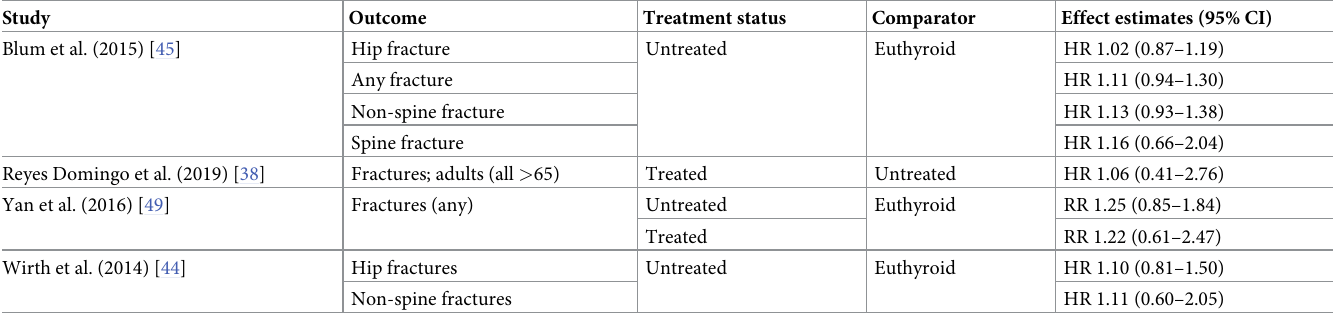
For the 5 studies that explicitly reported quality of life outcomes, no statistically significant dif- ferences were found between patients who did and did not receive treatment for SCH (Table 8). Similarly, thyroid-related symptoms, fatigue, mental and general well-being scores were not significantly associated with treatment status. However, Helfand [36] reported that specific subgroups–patients with TSH values greater than 10 mIU/L and those with a history of Graves’ disease seemed to benefit from treatment. Graves’ disease is an autoimmune thyroid disorder treated with antithyroid medication, radiotherapy or surgery [56]. Nonetheless, it is Table 7. Primary review findings on